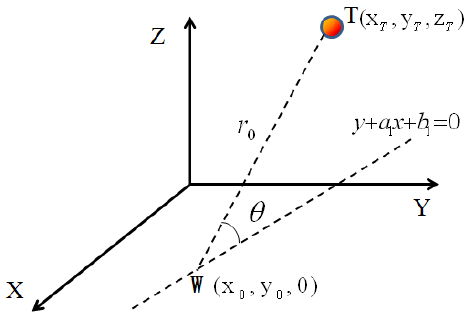
Figure 5. Schematic of angle scanning.